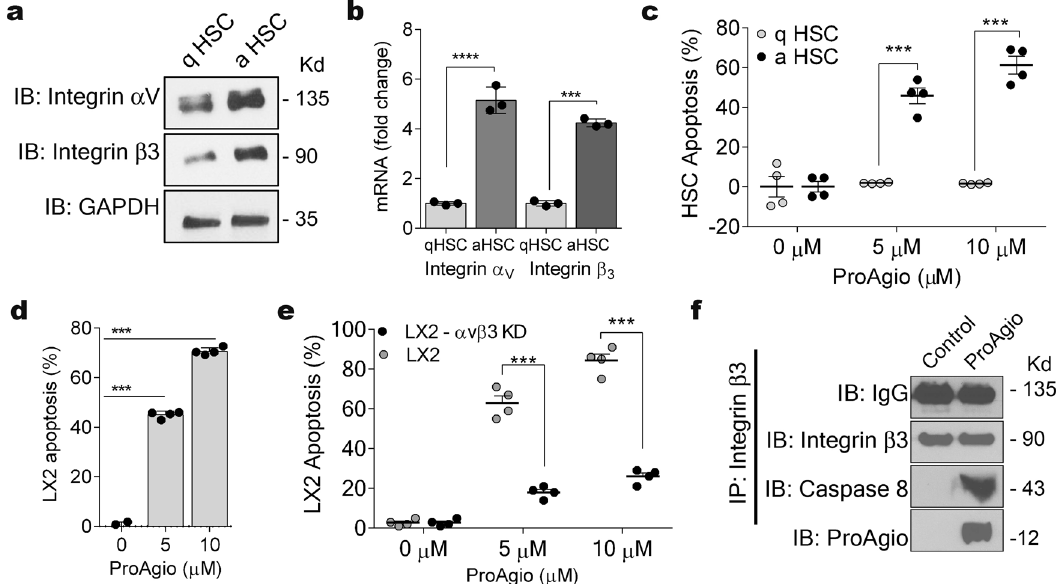
Fig. 1 ProAgio induces apoptosis of activated HSC. a Expression of integrin α v and β 3 in activated (an HSC) and inactivated (q HSC) human primary HSC cells were analyzed by immunoblots using anti- α v (IB: integrin α v) and anti- β 3 (IB: integrin β 3) antibodies. Immunoblot of GAPDH (IB: GAPDH) is a loading control. b mRNA levels of integrin α v and integrin β 3 in activated (an HSC) and inactivated (q HSC) human primary HSC cells were analyzed by RT-PCR. The integrin mRNAs are presented as fold changes by de fi ning the mRNA levels of inactivated HSC as 1. c – e Apoptosis of human primary HSC cells ( c ), LX- 2 cells ( d , e ) under treatment of indicated concentrations of ProAgio was measured by apoptosis kit. f Co-immunoprecipitations of caspase 8 with integrin β β 3 (IP:integrin 3 ) were analyzed by immunoblots (IB:caspase 8). LX-2 cells were treated with ProAgio 5 h prior to the preparation of extracts. Immunoblot of integrin β 3 (IB:integrin β 3 ) and IgG (IB:IgG) indicates the amount of β 3 and amounts of IgG, which were precipitated down in the co-IPs. c – e Apoptosis was presented as apoptosis (%) by de fi ning buffer treated cells as 0%. a – c Primary HSC cells were activated by culturing 7 days in presence of 5 ng/ml TGF- β (an HSC). Freshly plated cells were regarded as inactivated HSC cells (q HSC). Error bars in b – e are standard deviations of fi ve independent experiments. Statistical signi fi cance was calculated by two-tailed unpaired Student ’ s t test, *** P <